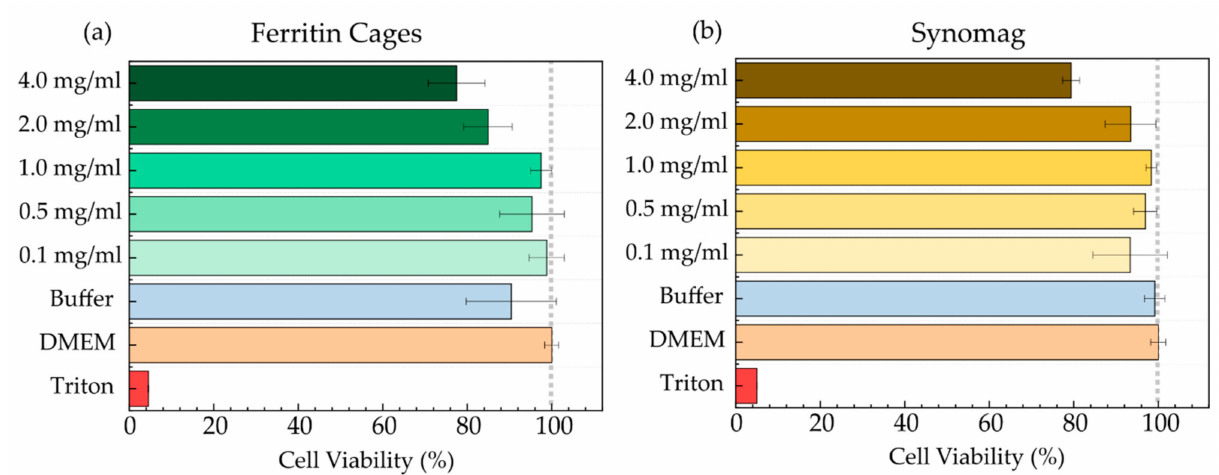
Figure 3. Cell viability Assay (CellTiter-Blue from Promega) measured after 24 h in HeLa WT cells for ( a ) ferritin cages and ( b ) synomag. Data was normalized to DMEM as positive control with untreated cells. Triton at 0.1% leads to cell death and was therefore used as negative control. The buffer control determines the effect of plain buffer on cell viability. The highest volume of MNP solution that was added during MNP addition was used here. Buffers were HEPES-2 for ferritin and PBS (pH 7.4) for synomag. Error bars represent the standard deviation of five measurements carried out for three biological replicates per